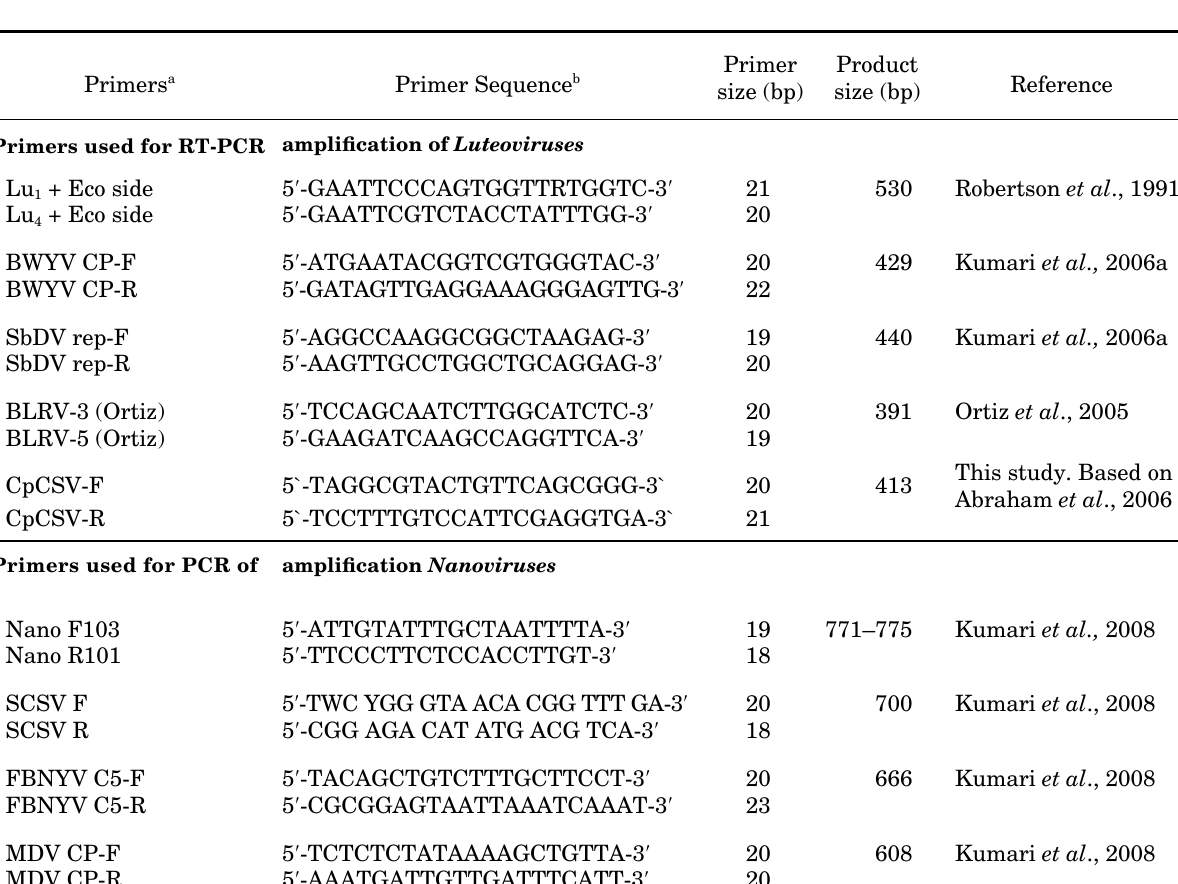
Table 1. Primers used for the detection of Luteoviruses and Nanoviruses by PCR.